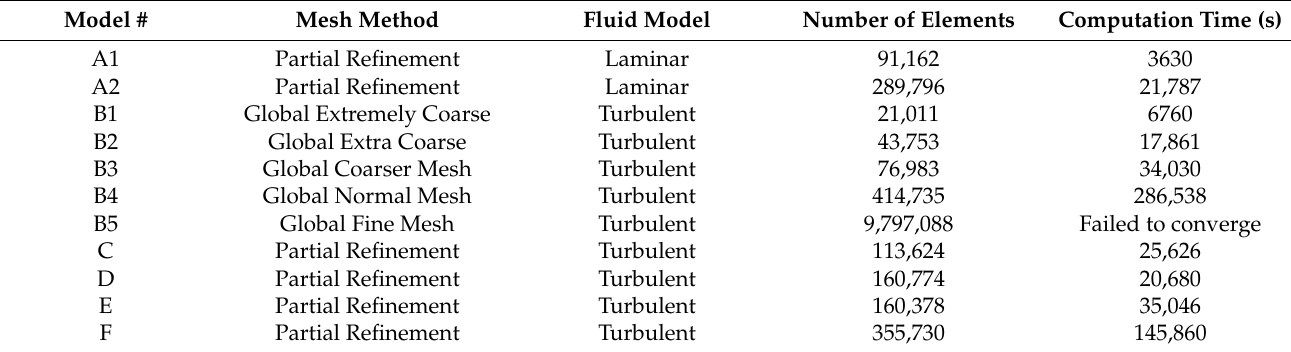
Table 7. This table lists CFD models used in this project and their associated number of elements and computation times. Only models A1 and A2 are executed using Laminar fluid model. All other models are executed using Turbulent model—RANS K- ε . All models are run in the HP ProBook, except Model